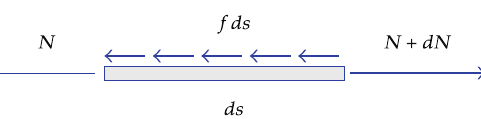
Figure 7: Forces on infinitesimal helix element d s